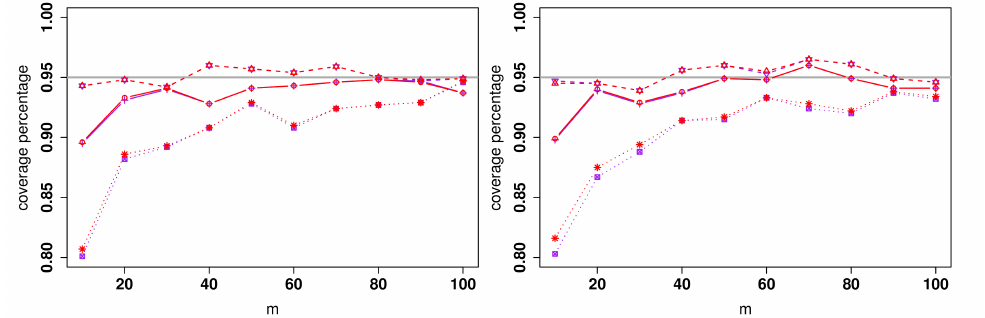
Figure 3. Comparison of the method in Hall et al. [6] (purple) and our method (red) for the 95% coverage percentage for β 0 , β 1 , and σ 2